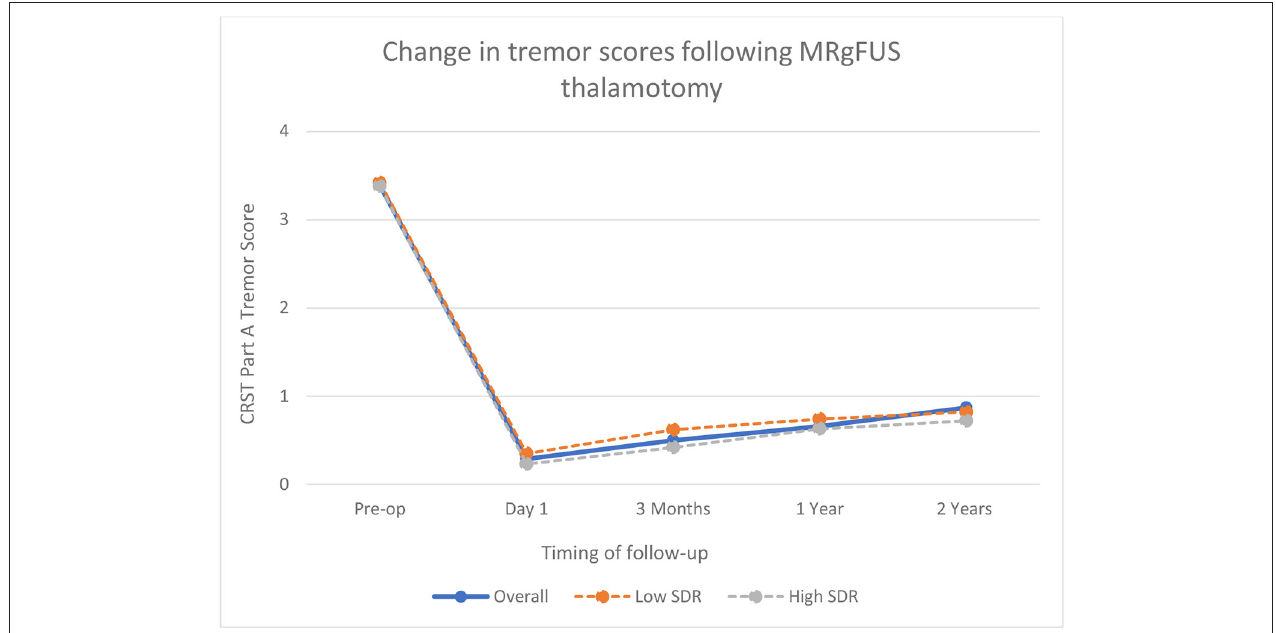
FIGURE 2 | Change in tremor scores following MRgFUS thalamotomy in Essential Tremor